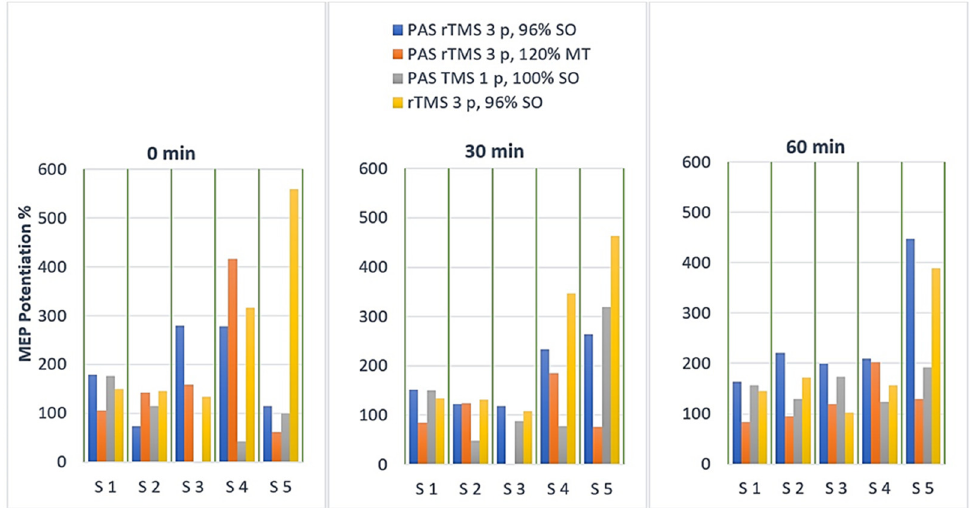
Figure 2. MEP potentiations elicited by the four different protocols at three post-stimulation time- points (immediately after the stimulation at 0 minute, after 30 minutes and after 60 minutes). The MEP measurements of subject 3 were omitted in two sessions due to a technical error.